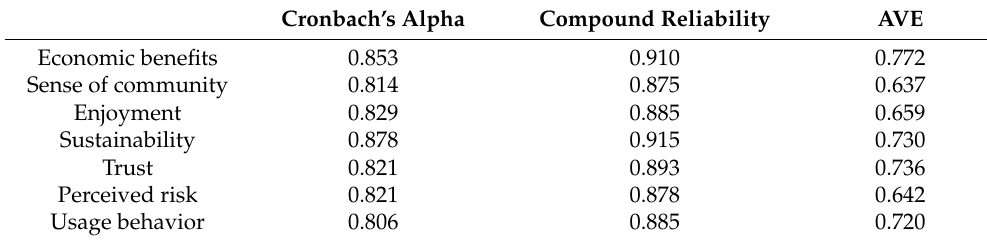
Table 4. Reliability and validity measures.